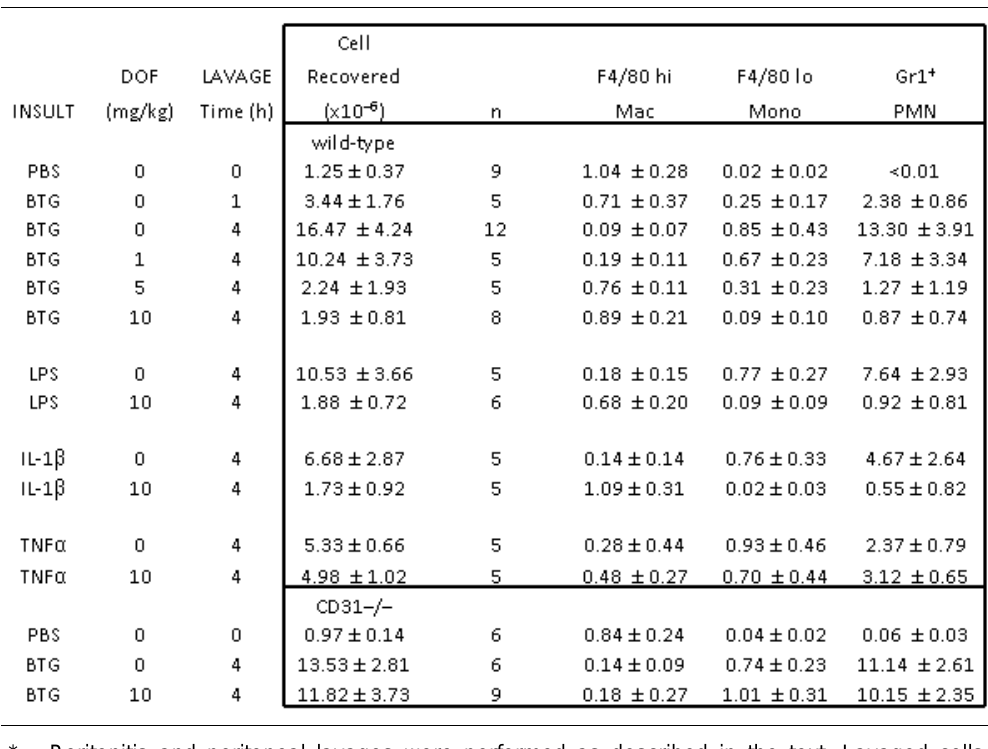
Effect of DOF on Sterile